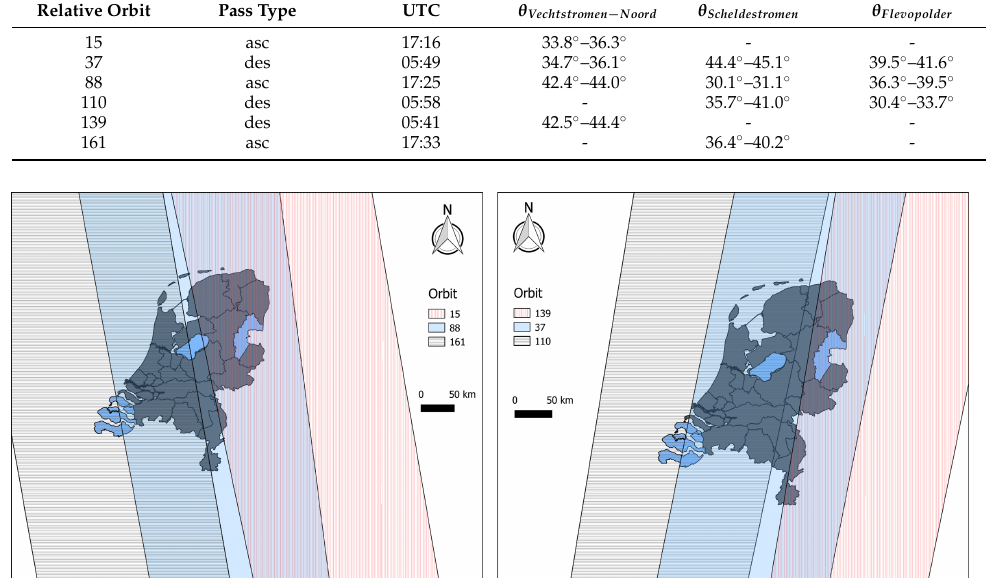
Table 2. Sentinel-1 orbits characteristic for the study areas.